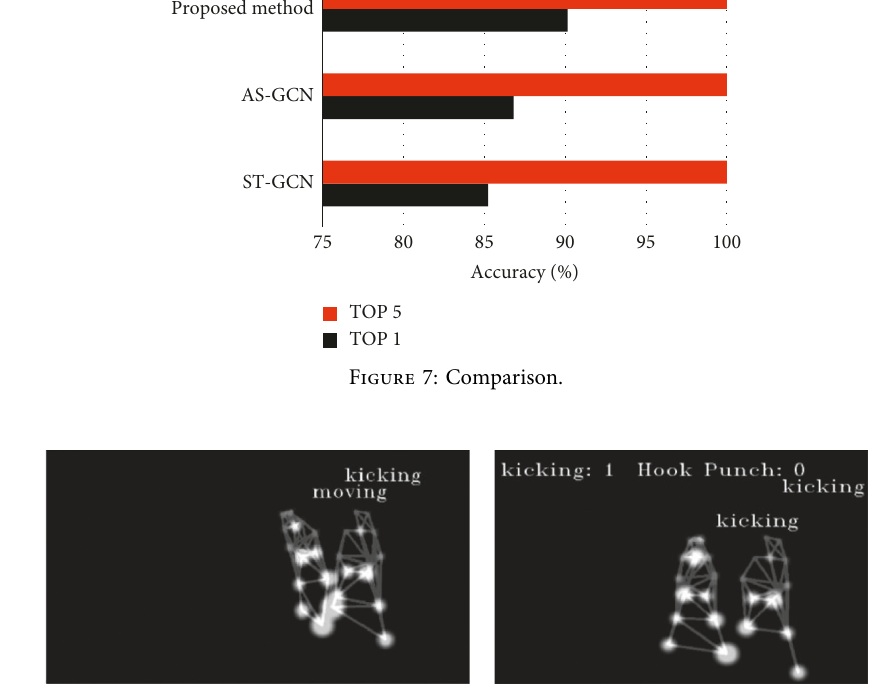
Figure 6: Predicted value.